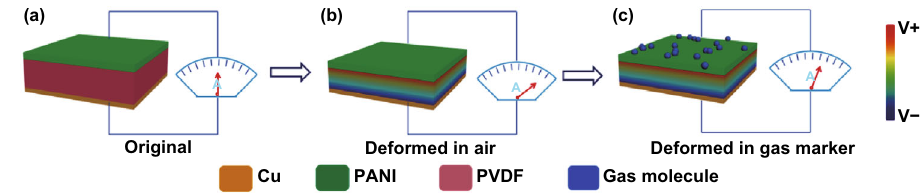
Fig. 8 Working principle of the device. a The original state of polarized PVDF. b Measuring the output current in air atmosphere. c Measuring the output current in gas marker